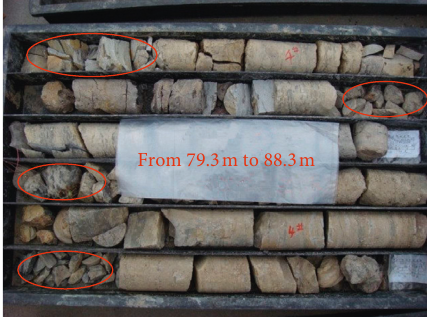
Figure 3: Characteristics of the borehole core in the upper section.